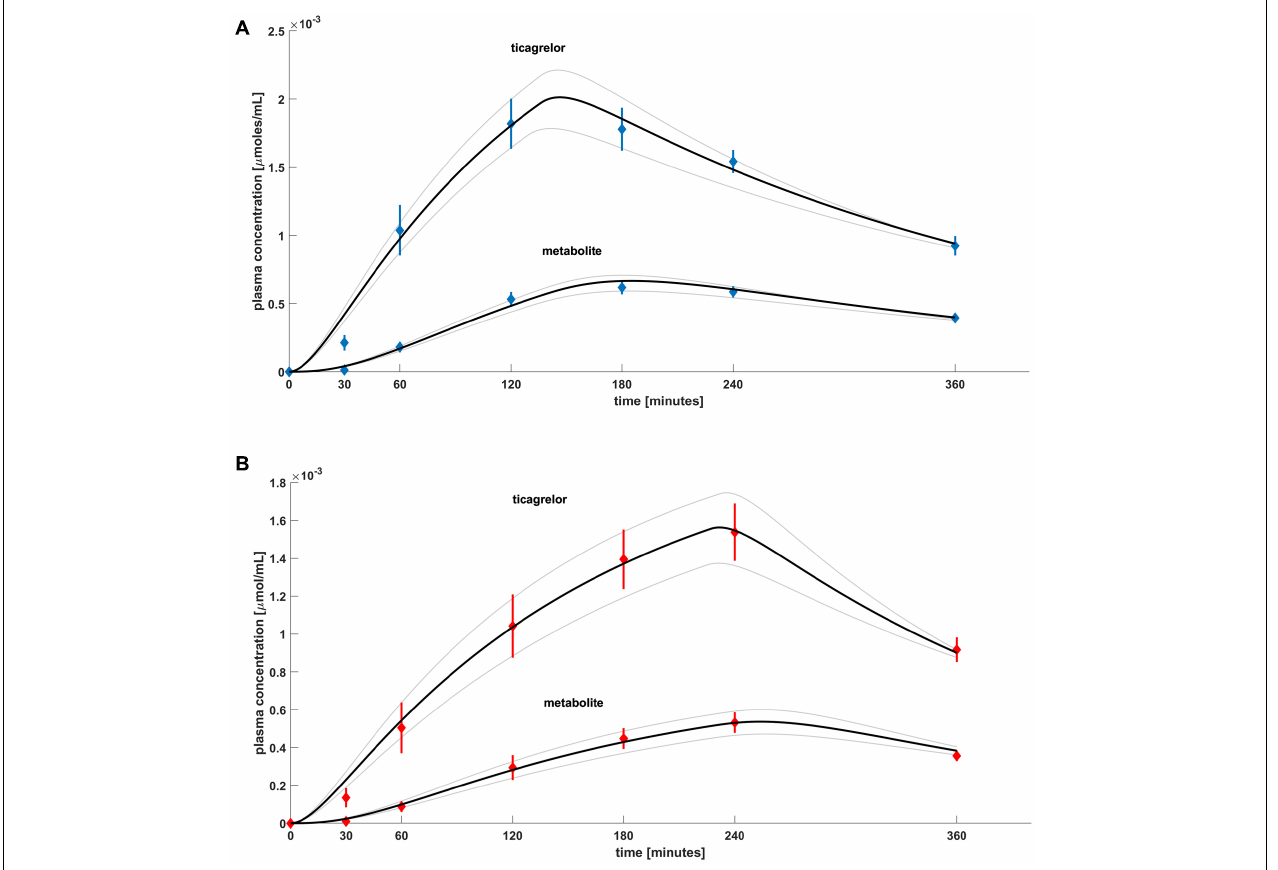
FIGURE 3 | Plasma concentration for (A) healthy volunteers after 180-mg ticagrelor loading dose and (B) healthy volunteers after 180-mg ticagrelor loading dose administered with 5-mg morphine, mean and SEM of experimental data. Diamonds represent mean of experimental data. Black lines are best-fitted curves from model, and gray lines represent family of possible solutions.